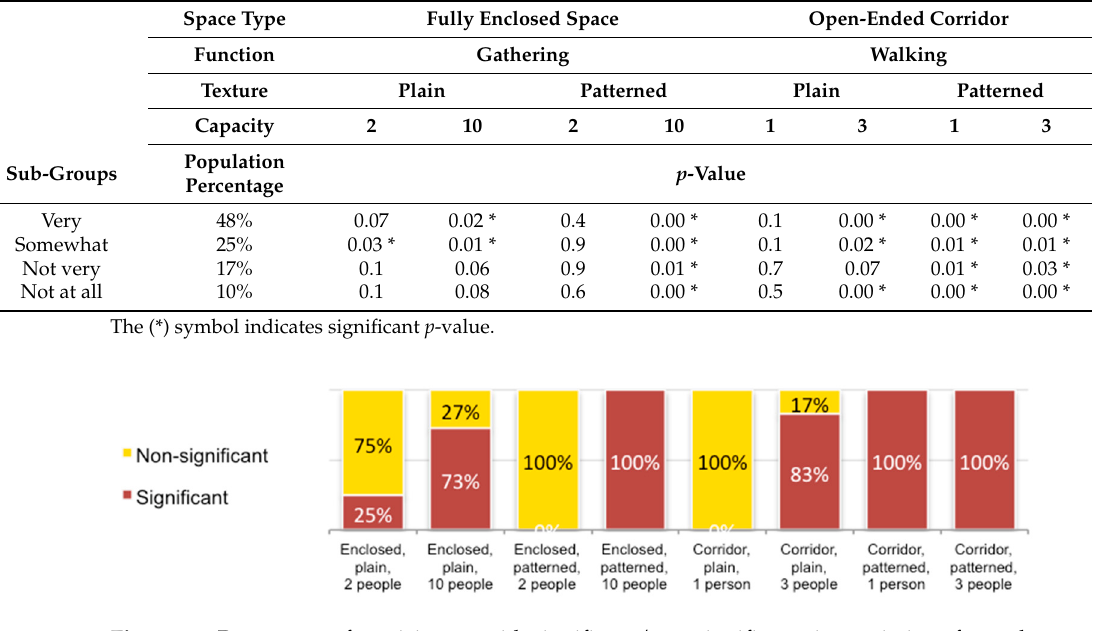
Figure 10. Percentage of participants with significant/non-significant size variations for each space in familiarity with 3D environments in DT system perception filter.